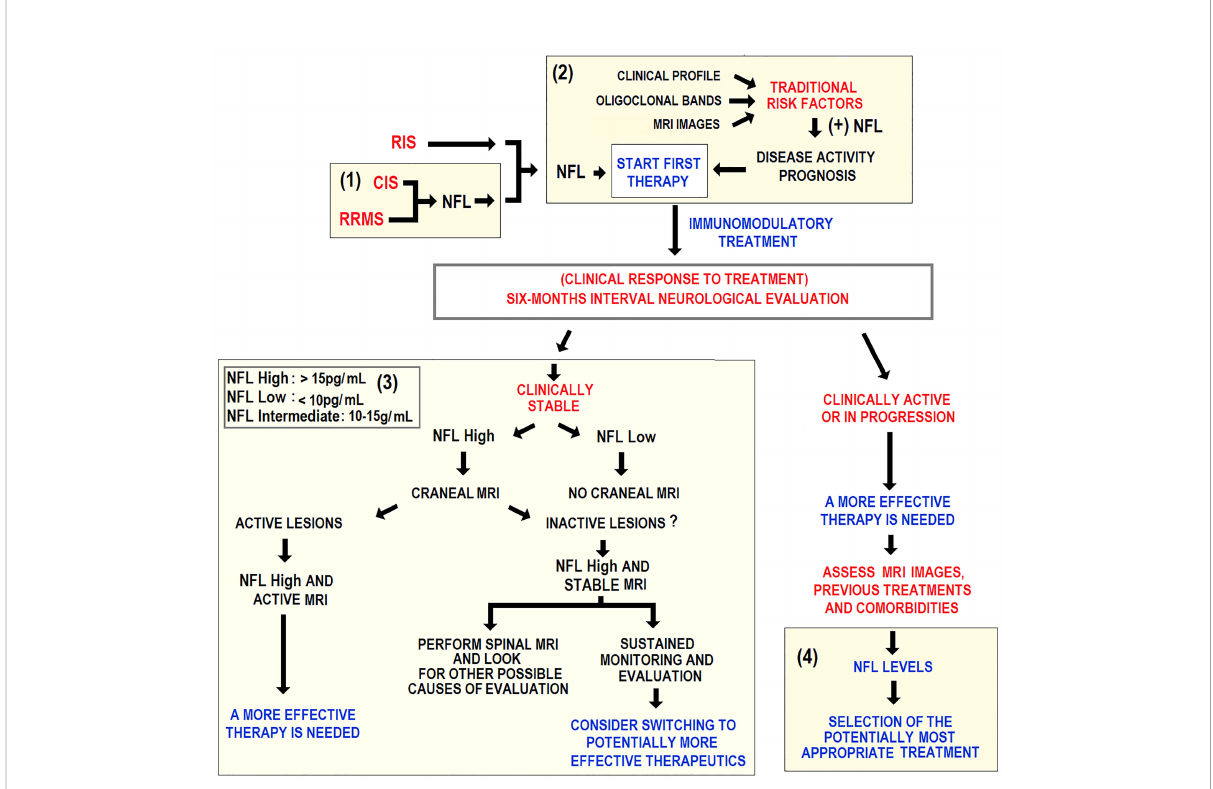
FIGURE 6 Schematic representation of an algorithm potentially applicable to clinical practice. Longitudinal sNFL measurement is considered for guiding clinical decision-making in RRMS treatment. Yellow fi elds mark four areas using sNFL as a guidance for decision-making in (1) initial diagnosis, (2) choice of initial treatment, (3) subclinical disease activity assessment, and (4) treatment optimization in clinically active